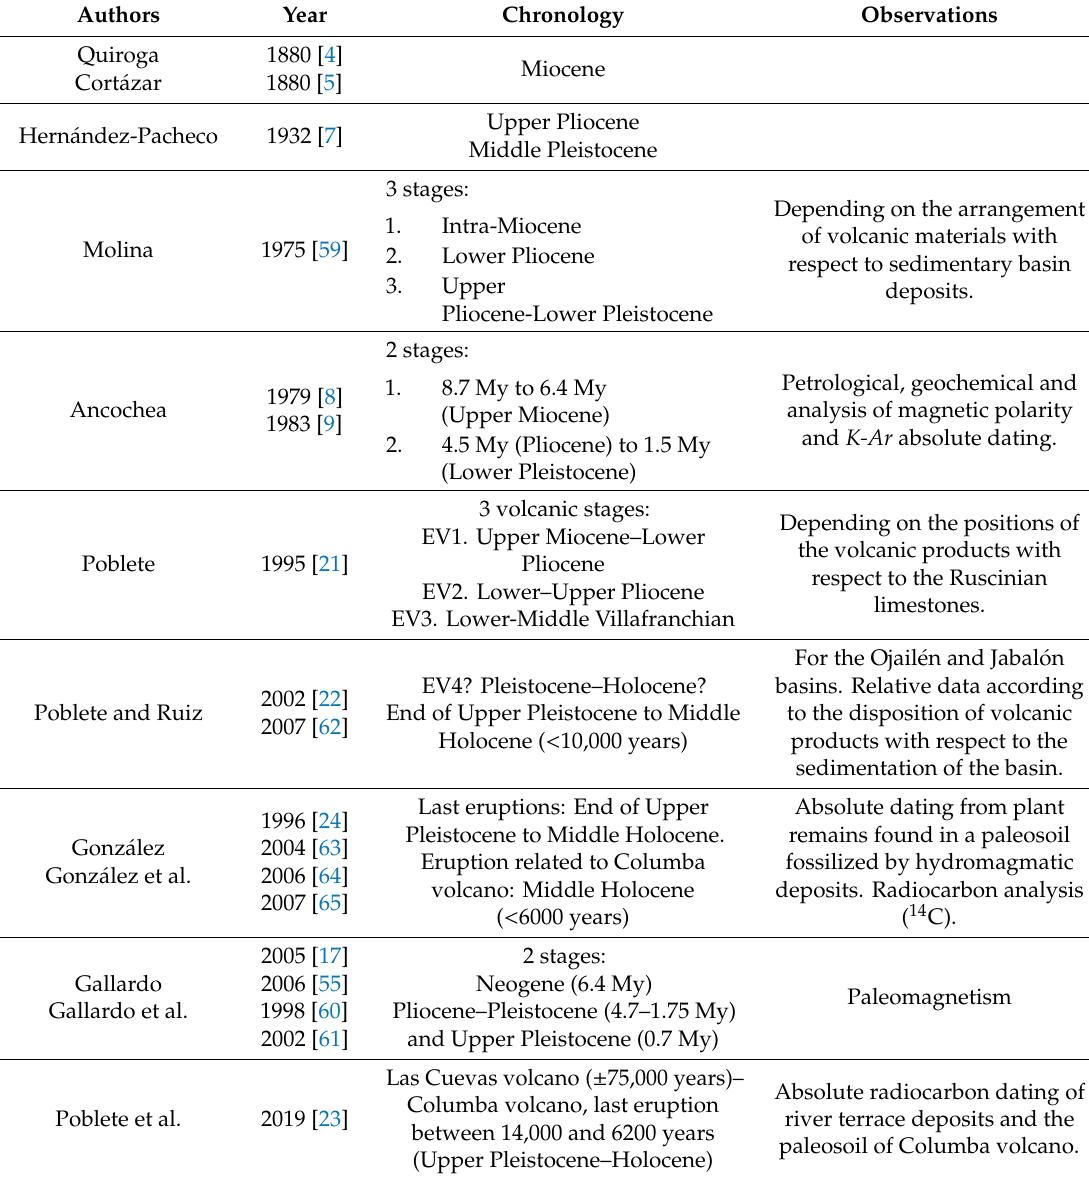
Table 2. Di ff erent interpretations of the chronology of the Campo de Calatrava Volcanic